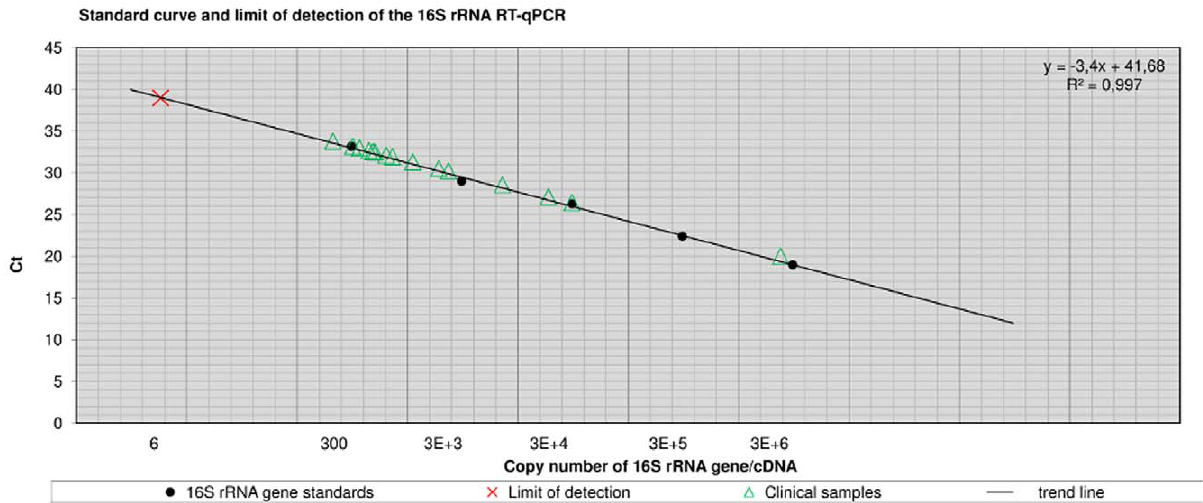
Figure 3. Standard curve and limit of detection of the 16S rRNA RT-qPCR. Figure 3 shows Ct-values of clinical samples plotted versus quantified 16S rRNA copy numbers. Standards for the 16S rRNA RT-qPCR were generated by conventional PCR amplification (Table 5). Log 10 fold serial dilutions ( n =5) were prepared ranging from 3E + 6 to 300 copies of the 16S rRNA gene (PCR template: 2 m l) and were subjected to the assay in quadruplicate to generate a calibration curve. The regression line was y= 2 3.4x + 41.68 with a coefficient of correlation . 0.99 and the efficiency was E=0.97. M. ulcerans whole genome extracts were quantified by means of IS 2404 qPCR and the analytical sensitivity was determined as limit of detection (LOD) by subjecting 10 aliquots of a dilution series containing 30, 15, 10, 8, 6, 3, or 2 copies of the 16S rRNA gene to the assay. The LOD was 6 copies of the target sequence. The copy number ( n =1) of the 16S rRNA gene per M. ulcerans genome was determined by copy number variation assay (unpublished data).